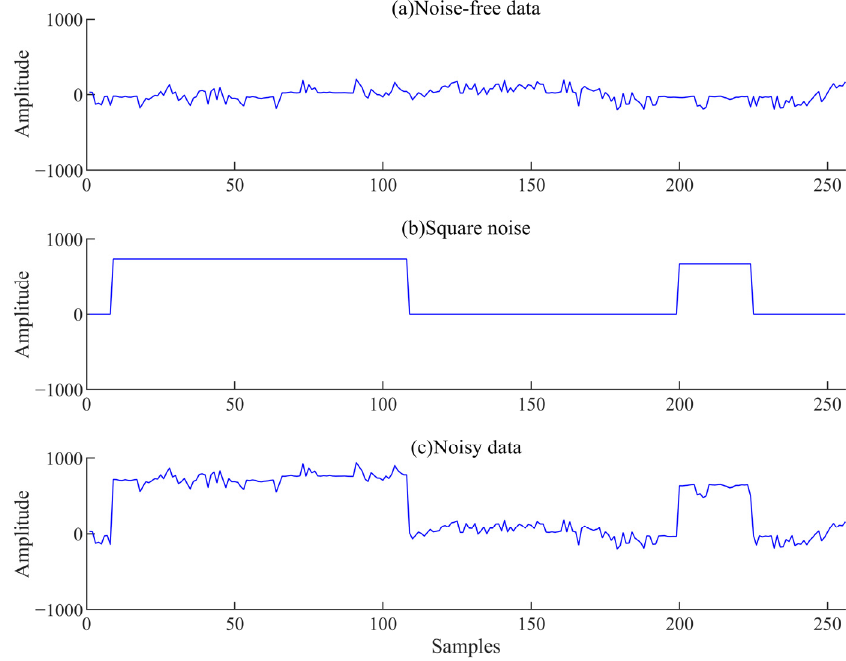
Figure 5. Synthesis of square noise. ( a ) Noise-free data, ( b ) square noise, ( c ) noisy data.